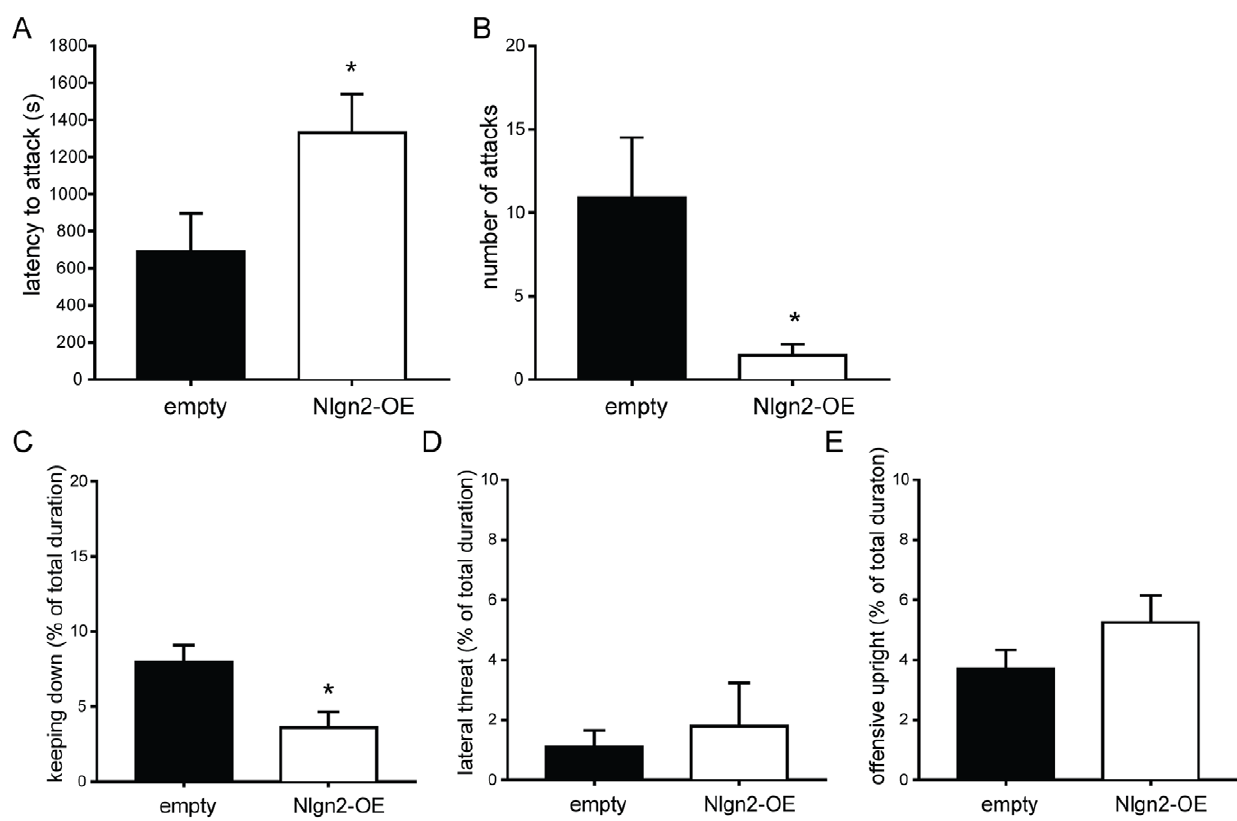
Figure 4. Aggression-related behavior. A, Latency to attack. In line with the number of attacks, nlgn2-OE animals had significantly longer latencies to attack the unfamiliar intruder than empty animals (empty 689.0 6 206.73, nlgn2-OE 1332.06 6 208.10, p , 0.05). B, Number of attacks during RI. Animals injected with nlgn2-OE virus showed significantly less attacks towards the intruder compared to control animals (empty 10.9 6 3.62, nlgn2-OE 1.44 6 0.67, p , 0.05). C, Keeping down behavior. Rats with the nlgn2-OE construct showed significantly less keeping down behavior towards the intruder compared to controls (empty 143.26 6 20.08, nlgn2-OE 64.89 6 18.90, p , 0.05). D–E, Lateral threat (D) and offensive upright (E). No differences could be observed concerning the aggression-related behaviors lateral threat (empty 19.91 6 9.79, nlgn2-OE 32.16 6 26.08, t-test ns) and offensive upright posture (empty 66.80 6 11.11, nlgn2-OE 94.51 6 16.08, t-test ns). Empty n=10, Nlgn2-OE n=9. ns=Not significant. *significantly different from empty animals.